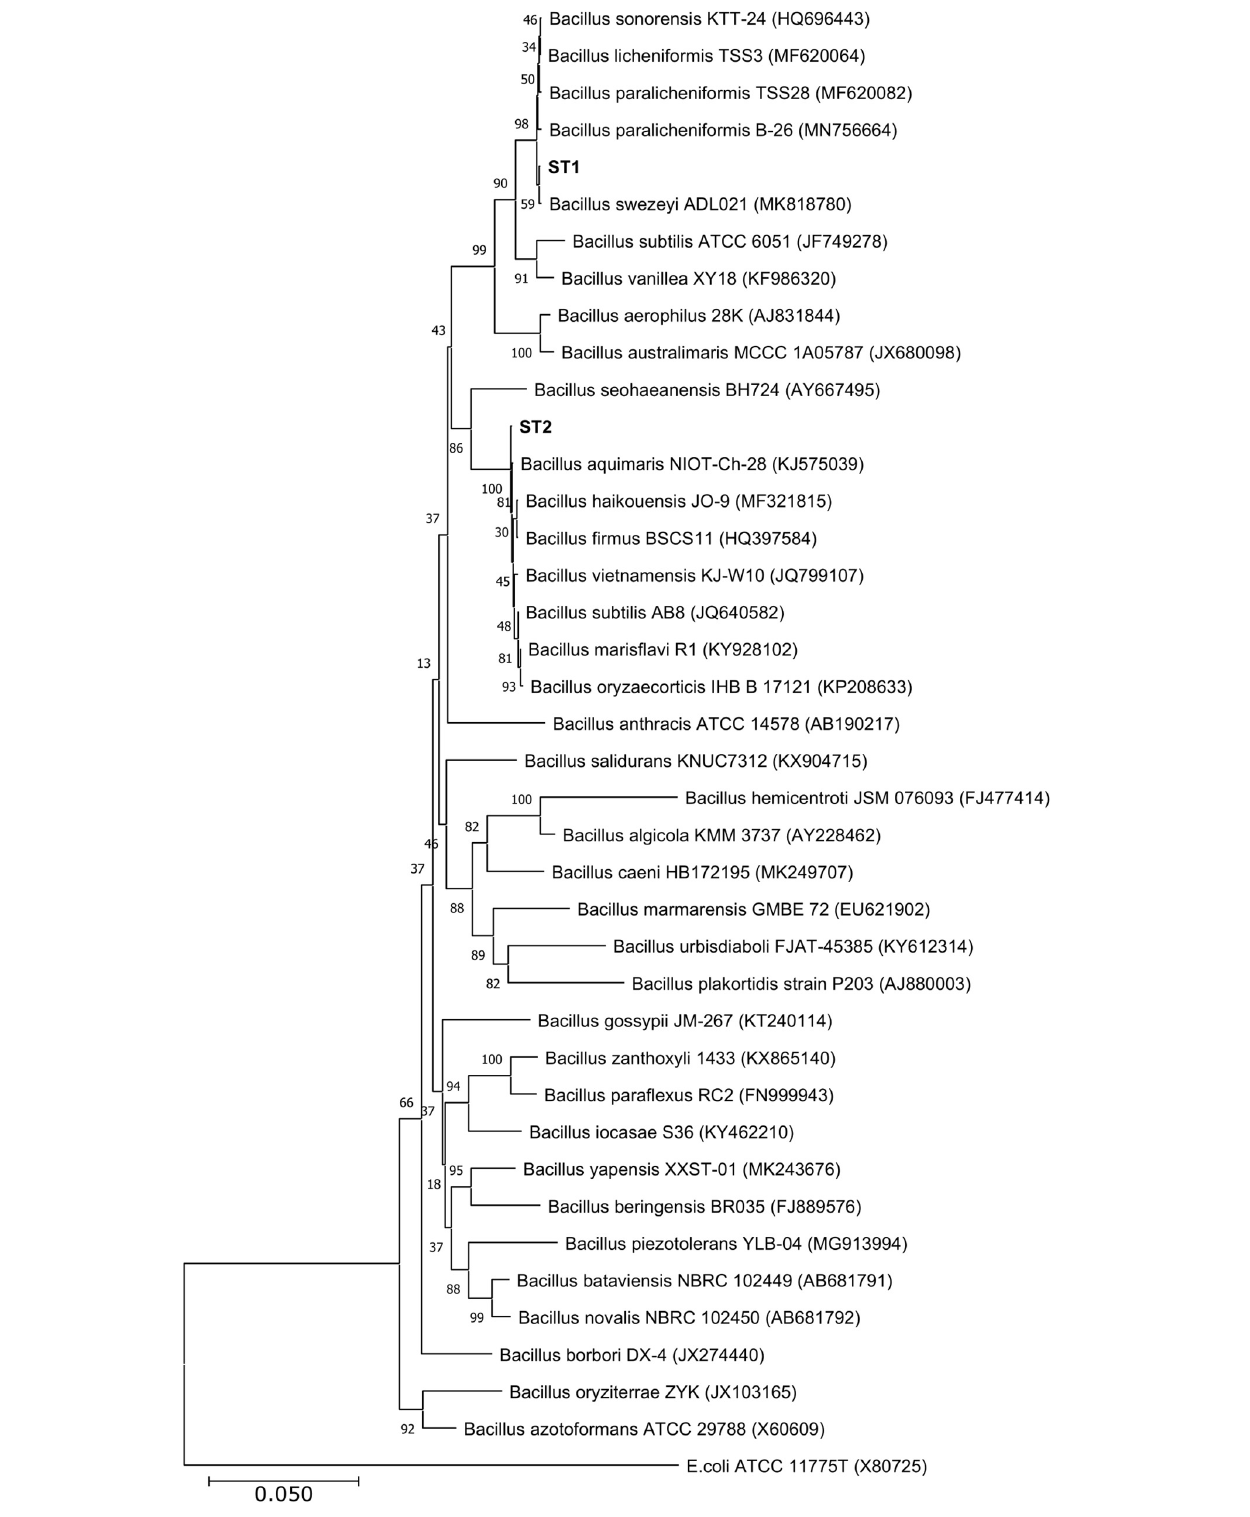
FIGURE 1 | Neighbor-joining phylogenetic tree showing the relationships between the salt-tolerant Bacillus strains from the present study (ST1 and ST2) and the closely related species. All ambiguous positions were removed for each sequence pair (pairwise deletion option). Escherichia coli ATCC 11775 was used as the